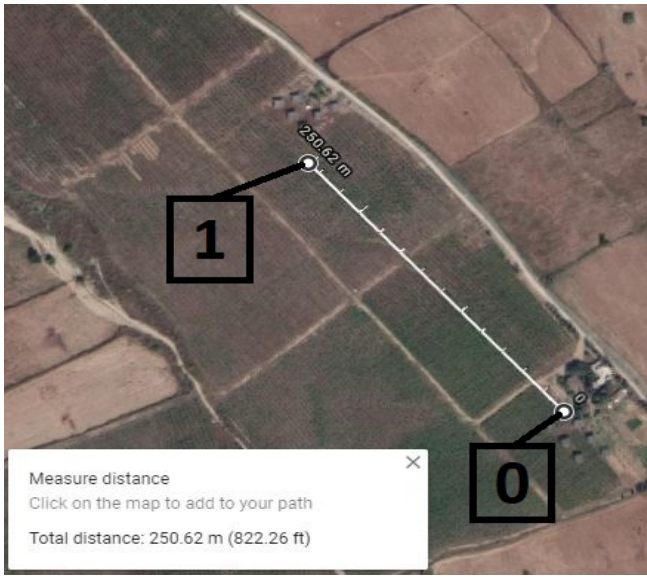
Figure 10. Point ‐ to ‐ point communication distance map Figure 10. Point-to-point communication distance